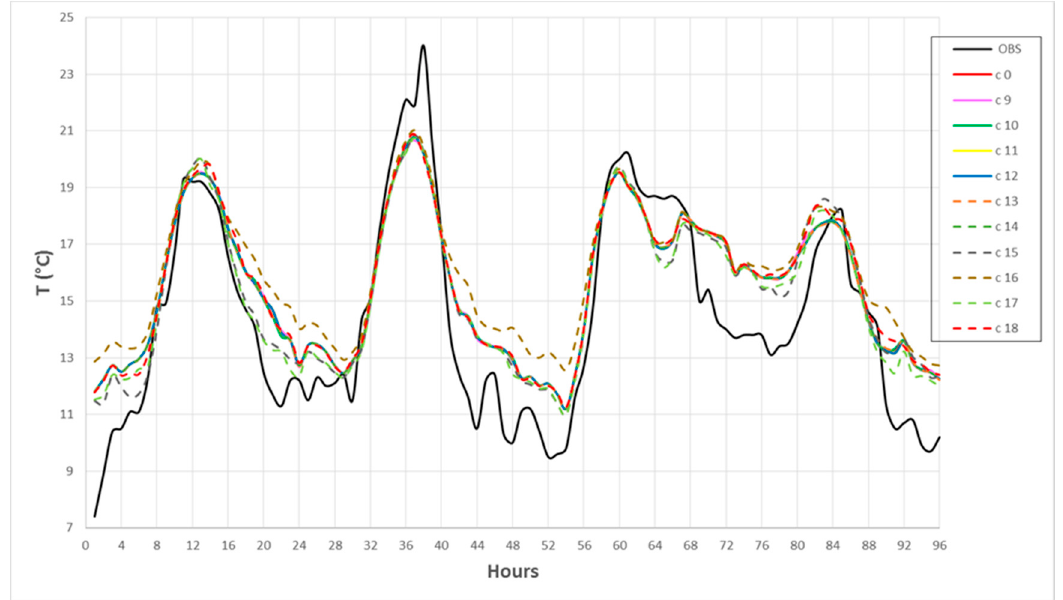
Figure 3. Time series of T2m (°C) at the CIRA site for event from 3 to 6 November 2017: observational and model data for reference configuration and sensitive configurations from c9 to